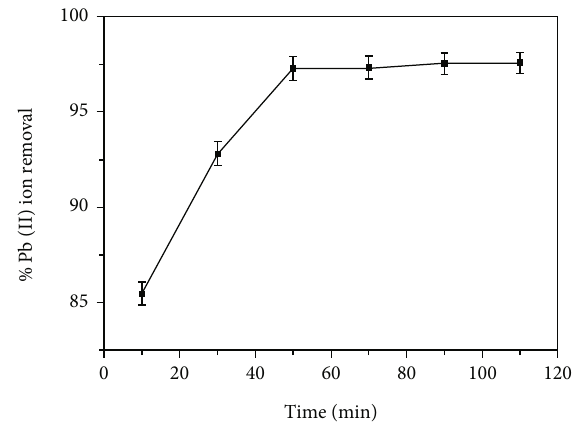
Figure 8: E ff ect of contacting time on adsorption behavior of Pb 2+ at constant lead (II) ion concentration of 100mg/L, agitation speed of 300 rpm, temperature of 25 ° C, pH of 6, and bioadsorbent dosage of